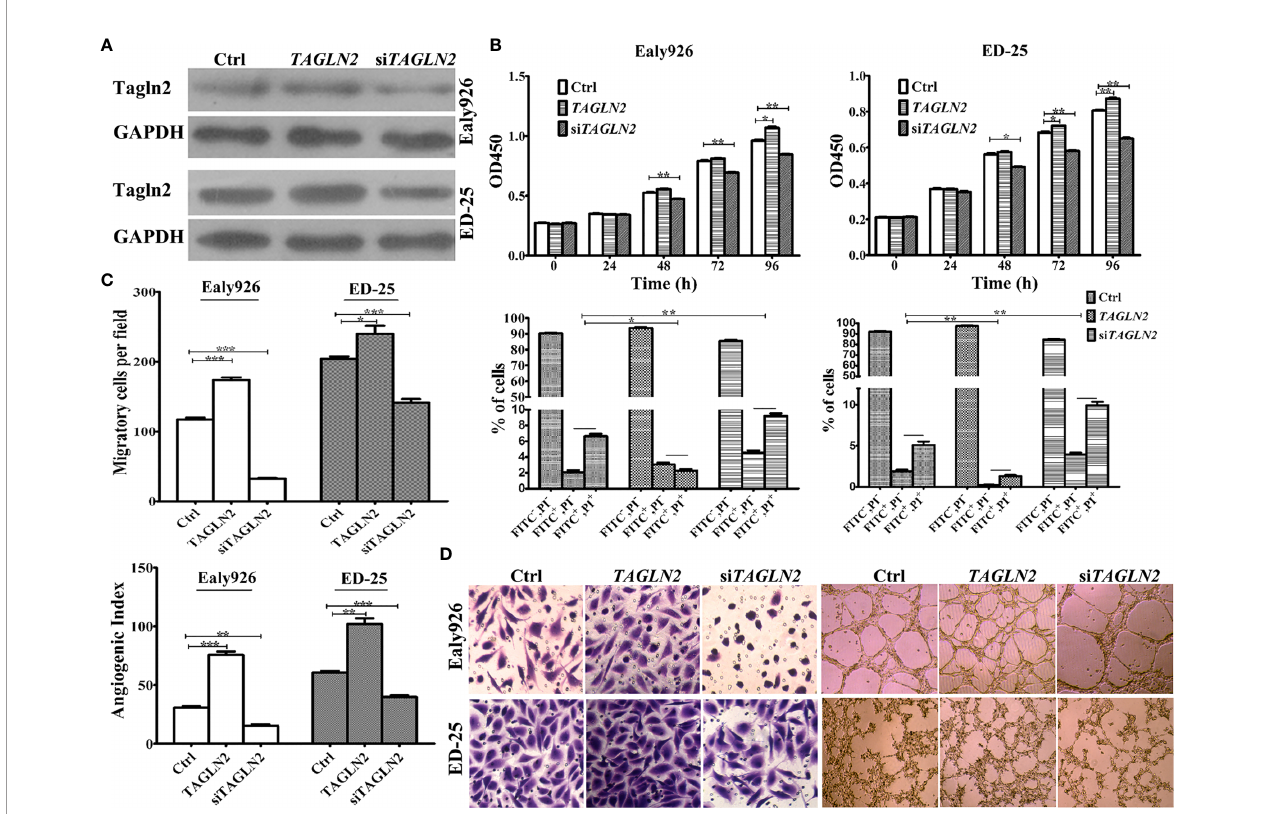
FIGURE 2 | In vitro assays of Tagln2 functions in the Ealy926 and ED-25 cell lines with Tagln2 overexpression or knockdown. (A) Ef fi cient Tagln2 overexpression or knockdown was con fi rmed by western blotting. (B) Survival and apoptosis assays with Ealy926 and ED-25 cells after Tagln2 overexpression or knockdown. (C, D) Migration and in vitro tube-forming activity of Ealy926 and ED-25 cells after Tagln2 overexpression or knockdown. Cell numbers were counted in fi ve randomly selected fi elds under a microscope. * P < 0.05, ** P < 0.01, *** P <